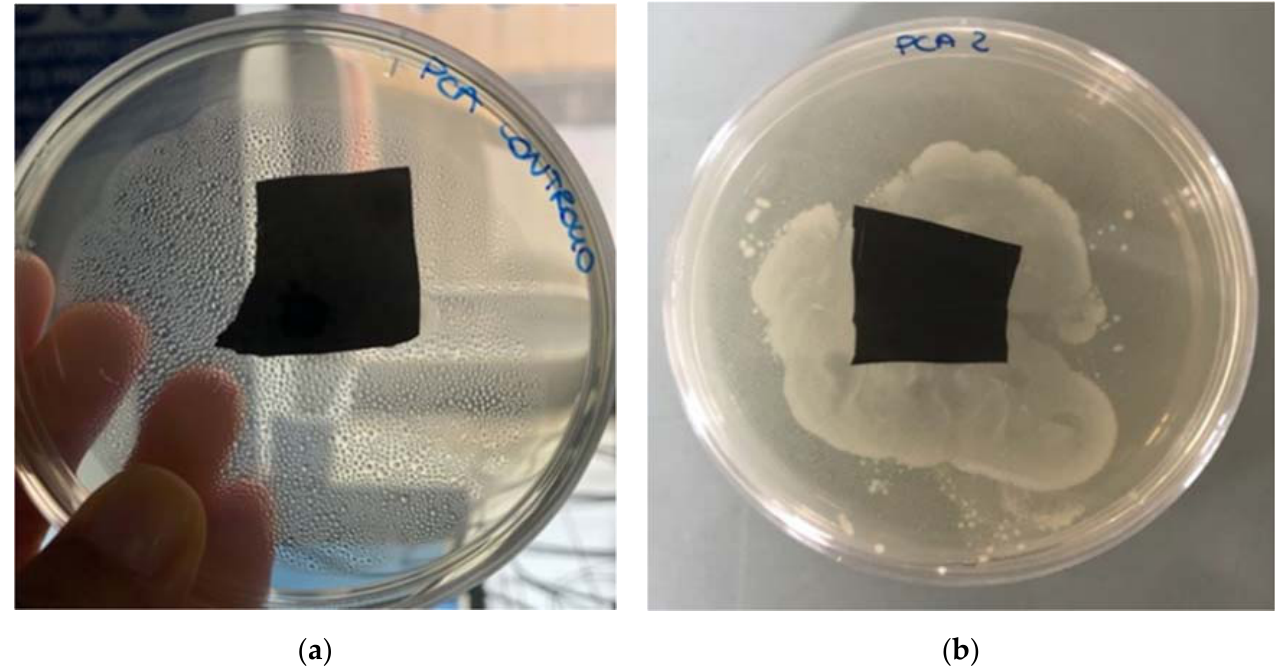
Figure 3. ( a ) BP film not inoculated as control and ( b ) BP film 14 days after the inoculation with Pseudomonas putida .